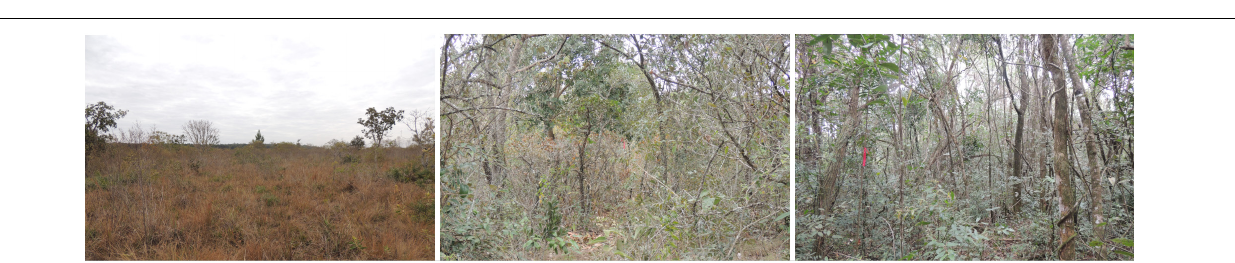
Table 1 ). PT and LT transects were checked daily. Capture